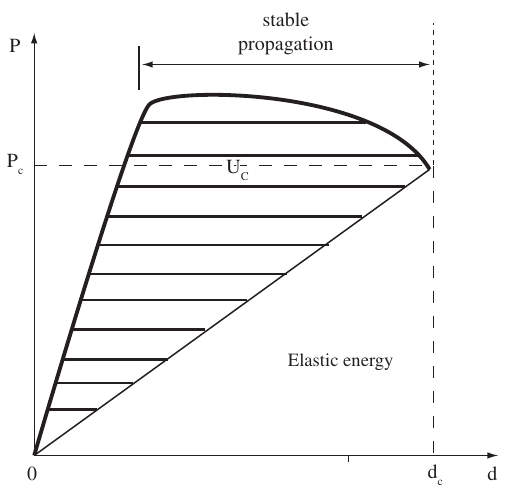
, Figure 8. Critical crack length, a wof